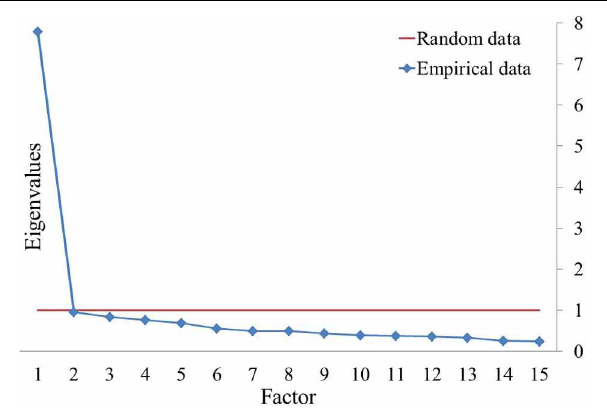
FIGURE 2 | Scree plot and parallel analysis of eigenvalues in